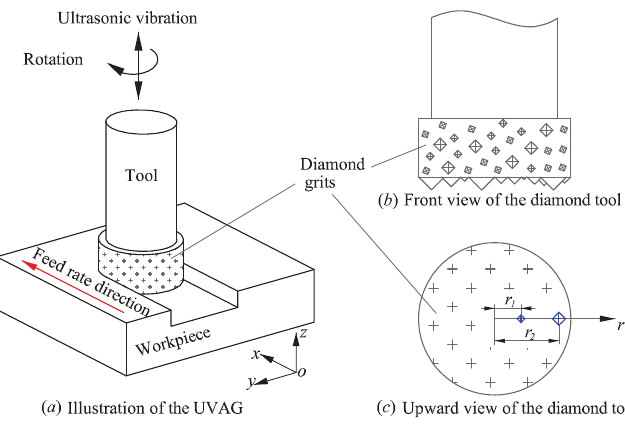
Figure 3. Random distribution of the grits on the UVAG tool.